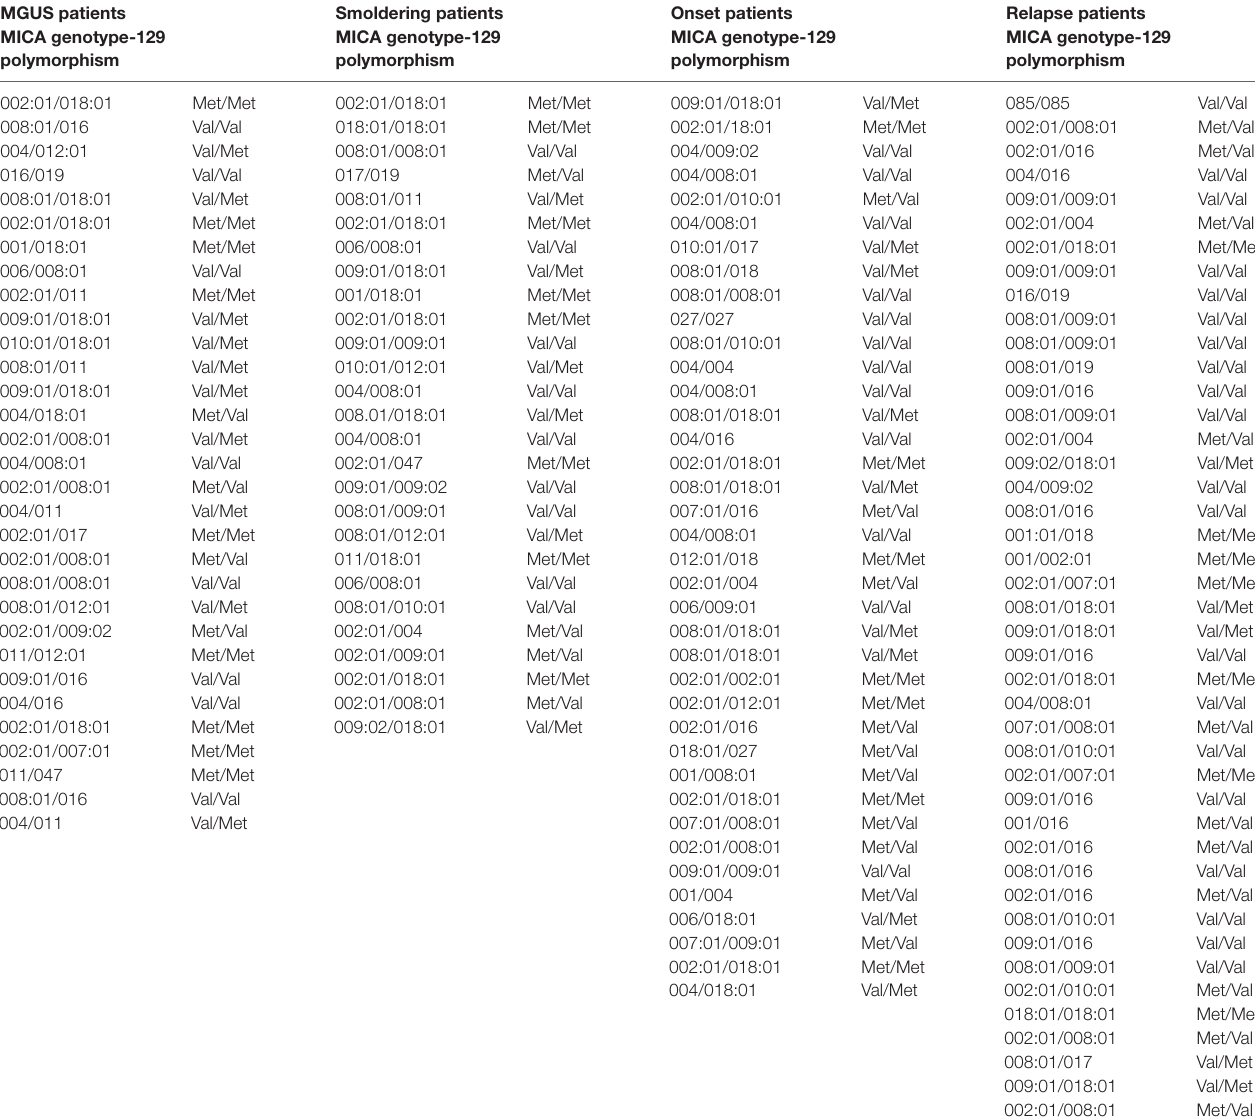
TaBle 1 | MICA genotype and 129 polymorphism in patients at different disease